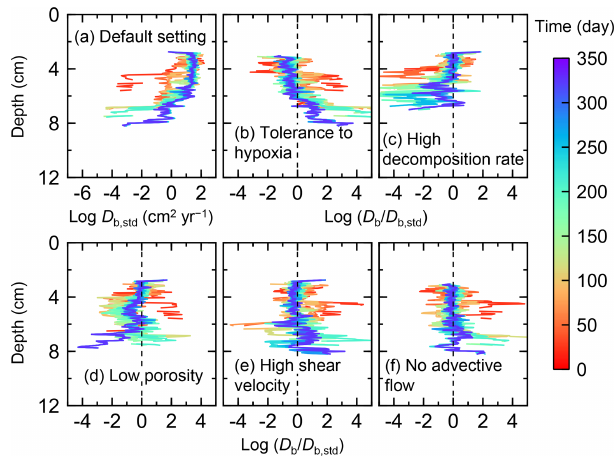
Figure 7. Time evolution of the biodiffusion coefficient ( D b ) ob- tained from 1-year simulations with eLABS. See Sect. 3.1 and cap- tion of Fig. 4 for the details of simulations (a–f) . Note that D b values are presented only for simulation (a) (denoted as D b , std ); for other simulations (b–f) , the ratios of D b values to those in panel (a) ( D b /D b , std ) are shown to facilitate comparison and dashed vertical lines are references to denote D b = D b , std . Plotted are these values/ratios at 25, 50, 75... 350 model days from the start of the